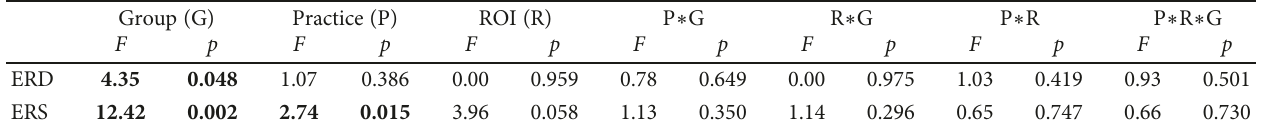
Figure 4: Average peak latencies of ERD (a, c) and ERS (b, d) for each set in the younger (grey circles and lines) and older (black circles and lines) groups for the left (upper graphs, a and b) and frontal (lower graphs, c and d) ROIs. The vertical bars represent the standard error of the mean. Table 3: Result of repeated measure ANOVAs for ERD and ERS peak